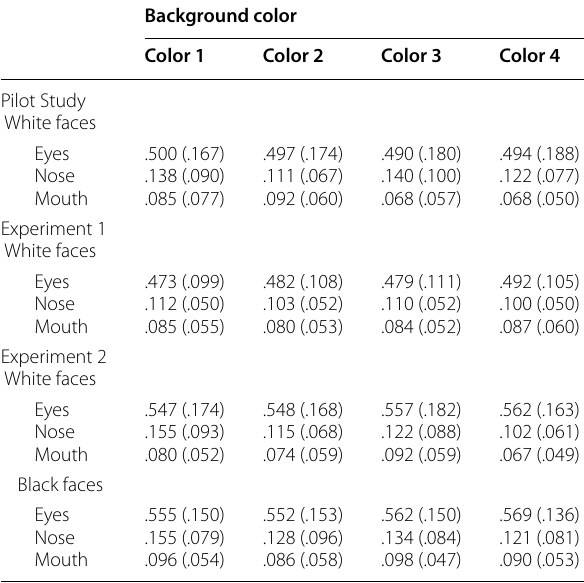
Table 1 Mean and standard deviations of proportion of visual attention to the eyes, nose, and mouth by background color for the Pilot Study, Experiment 1, and Experiment